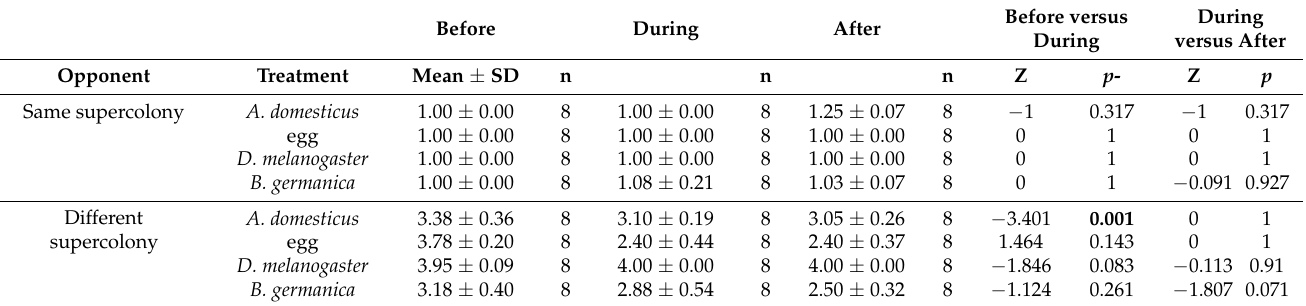
Table 2. Mean level of aggression ± SD, before, during and after the dietary experiments in the laboratory. Z scores and p values are from Mann-Whitney U-tests. Bold indicates p < 0.05. Before During After